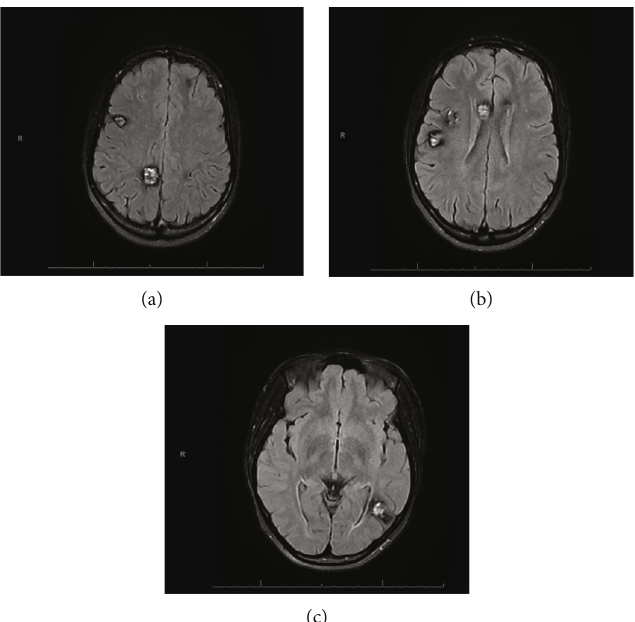
Figure 1: Axial T2 FLAIR sections (superior to inferior) from an MRI performed upon the patient ’ s arrival to the hospital. Various cavernomas are present. The largest lesion in the right cerebral hemisphere is in the paramedian right parietal lobe and measures 15 × 18 mm on axial images and 17mm superior to inferior (a). The largest lesion is in the posterior left temporal lobe near the temporal occipital junction and measures approximately 19 × 16 mm on axial images and 17mm superior to inferior